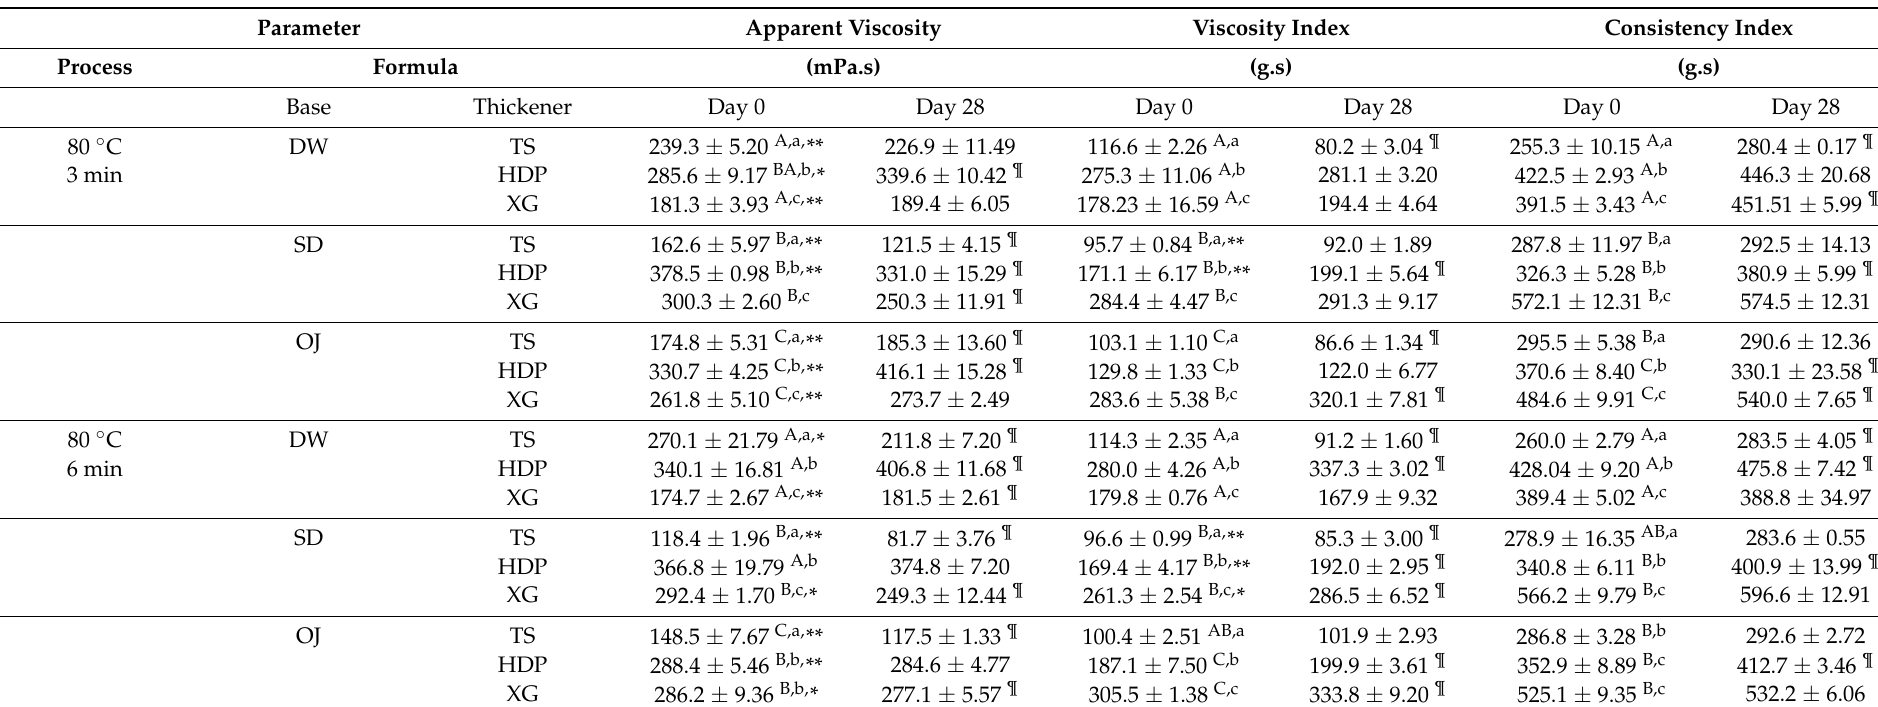
Table 8. Textural parameter variations due to thermal processing, aquatic continuous phases, and commercial thickeners prior to and after a 28 day storage at 4 ◦ C facilitated by thermal processes of 80 ◦ C-3/6